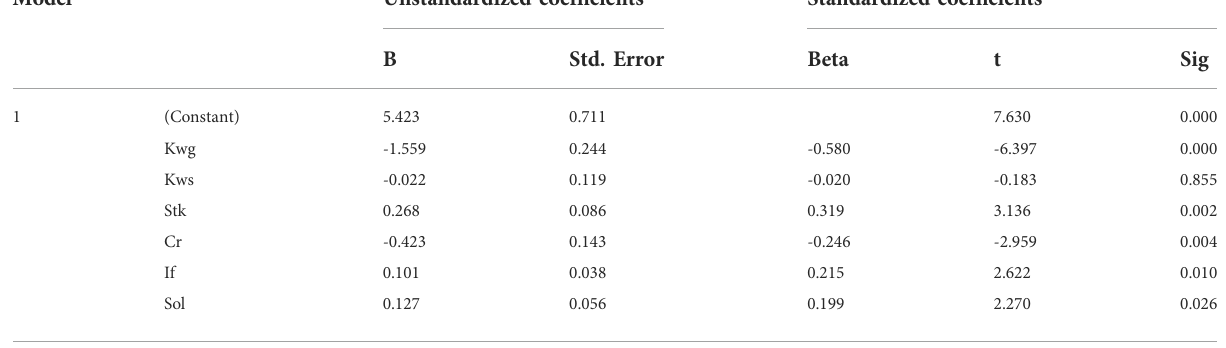
TABLE 14 Coef fi cients of the independent variables for Pi.